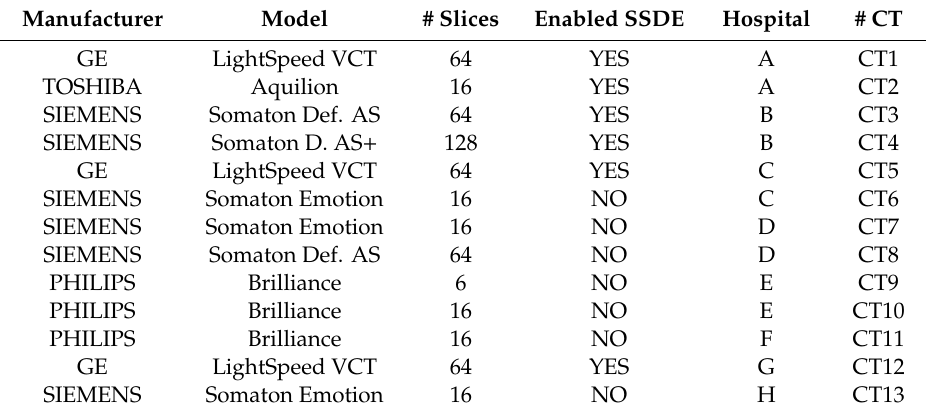
Table 1. Technical information on each computed axial tomography (CT) used in this work.